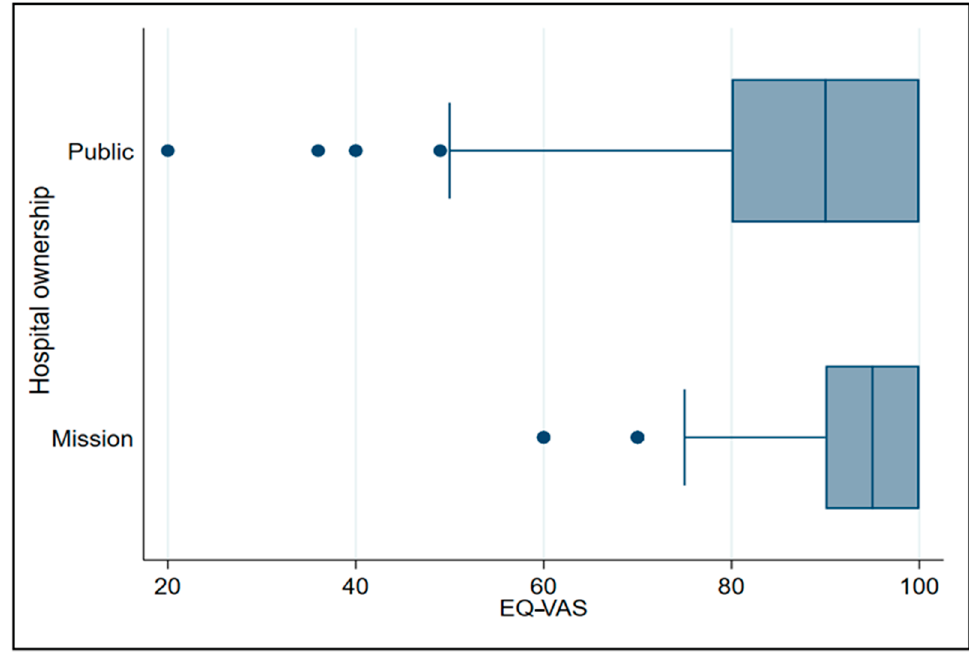
Figure 1. Box-and-whisker plot of EuroQol Visual Analogue Scale (EQ-VAS) by hospital owner- ship.